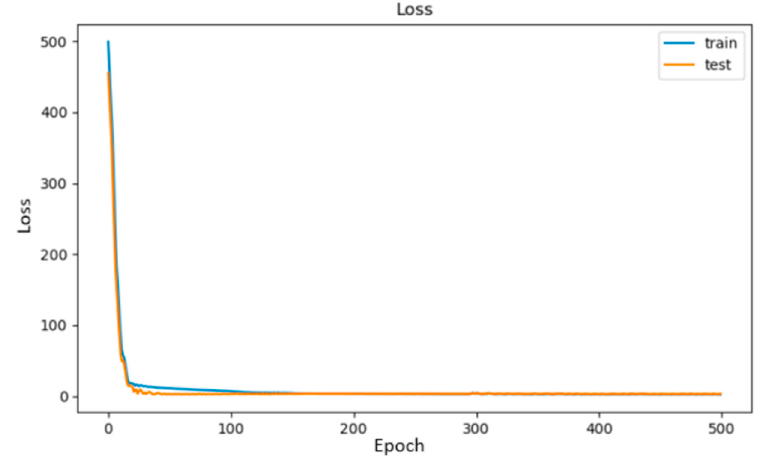
Figure 6. Loss/Epoch testing Figure 6 Loss/Epoch testing results.